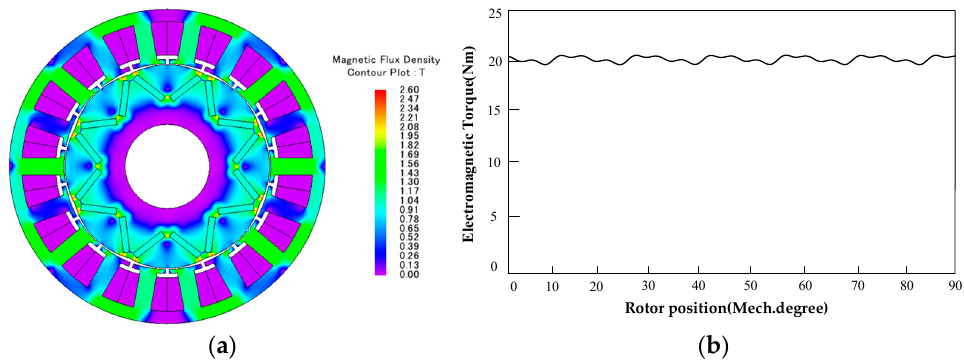
Figure 16. ( a ) Magnetic flux density plot at rated load ( b ) Electromagnetic torque at rated load.